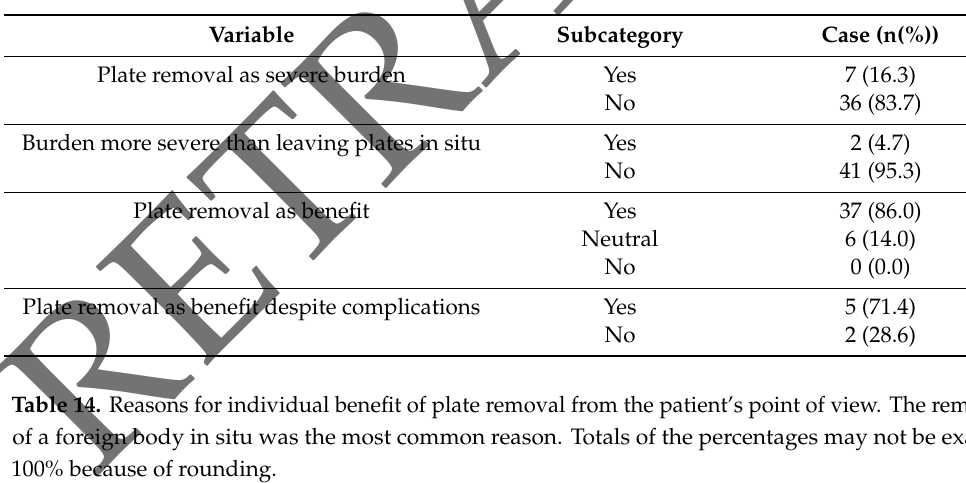
Table 13. Evaluation of the survey.